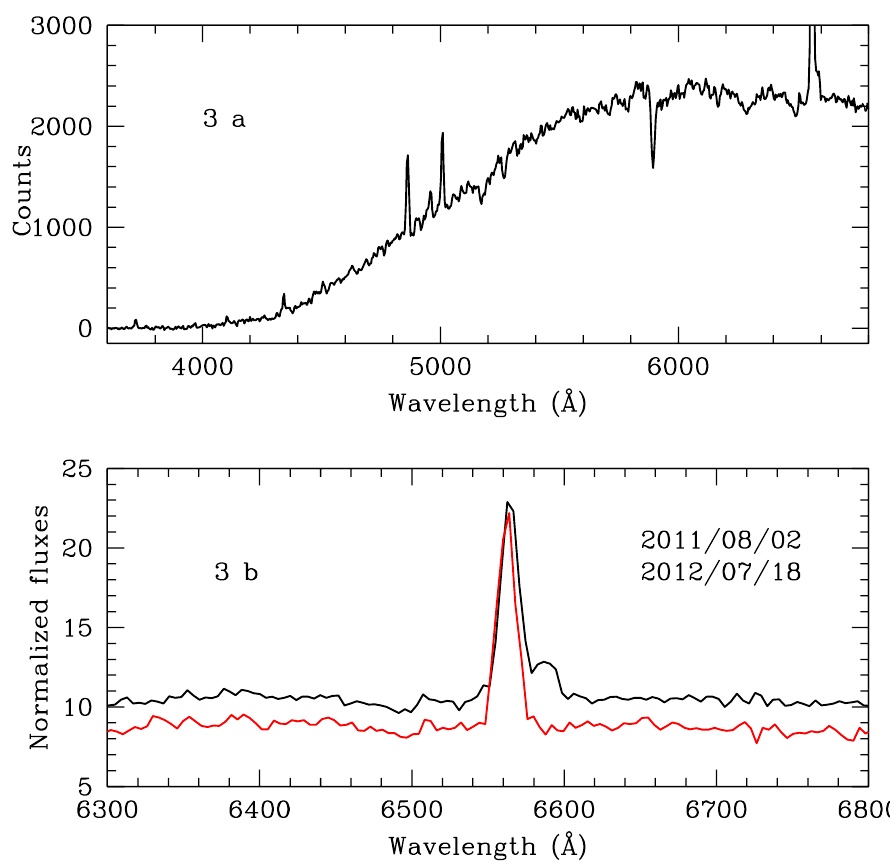
Fig. 3. Upper panel: the wavelength calibrated spectrum of V2282 Sgr showing the emission lines of hydrogen, [N II] 6584 ˚A, [O III] 5007/4959 ˚A, and [O II] 3727/29 ˚A. Lower panel: enlargement of the spectra of V2282 Sgr taken in 2011 August (upper line)